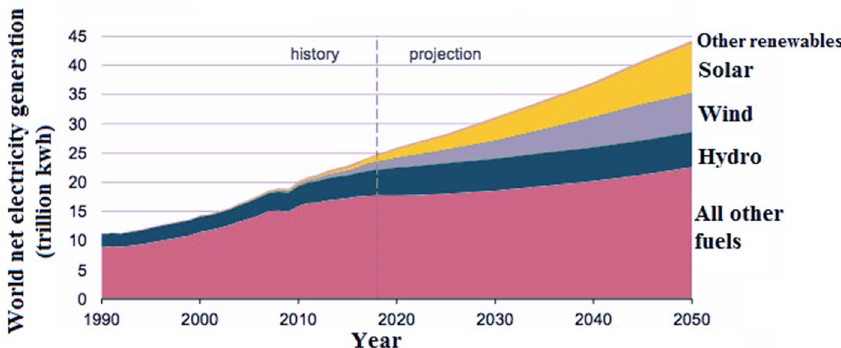
Fig. 20 The trend of world net electricity generation by differ- ent energy resources (EIA